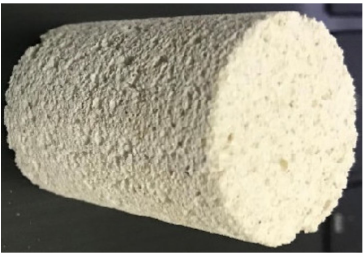
Figure 4. Aerated concrete core